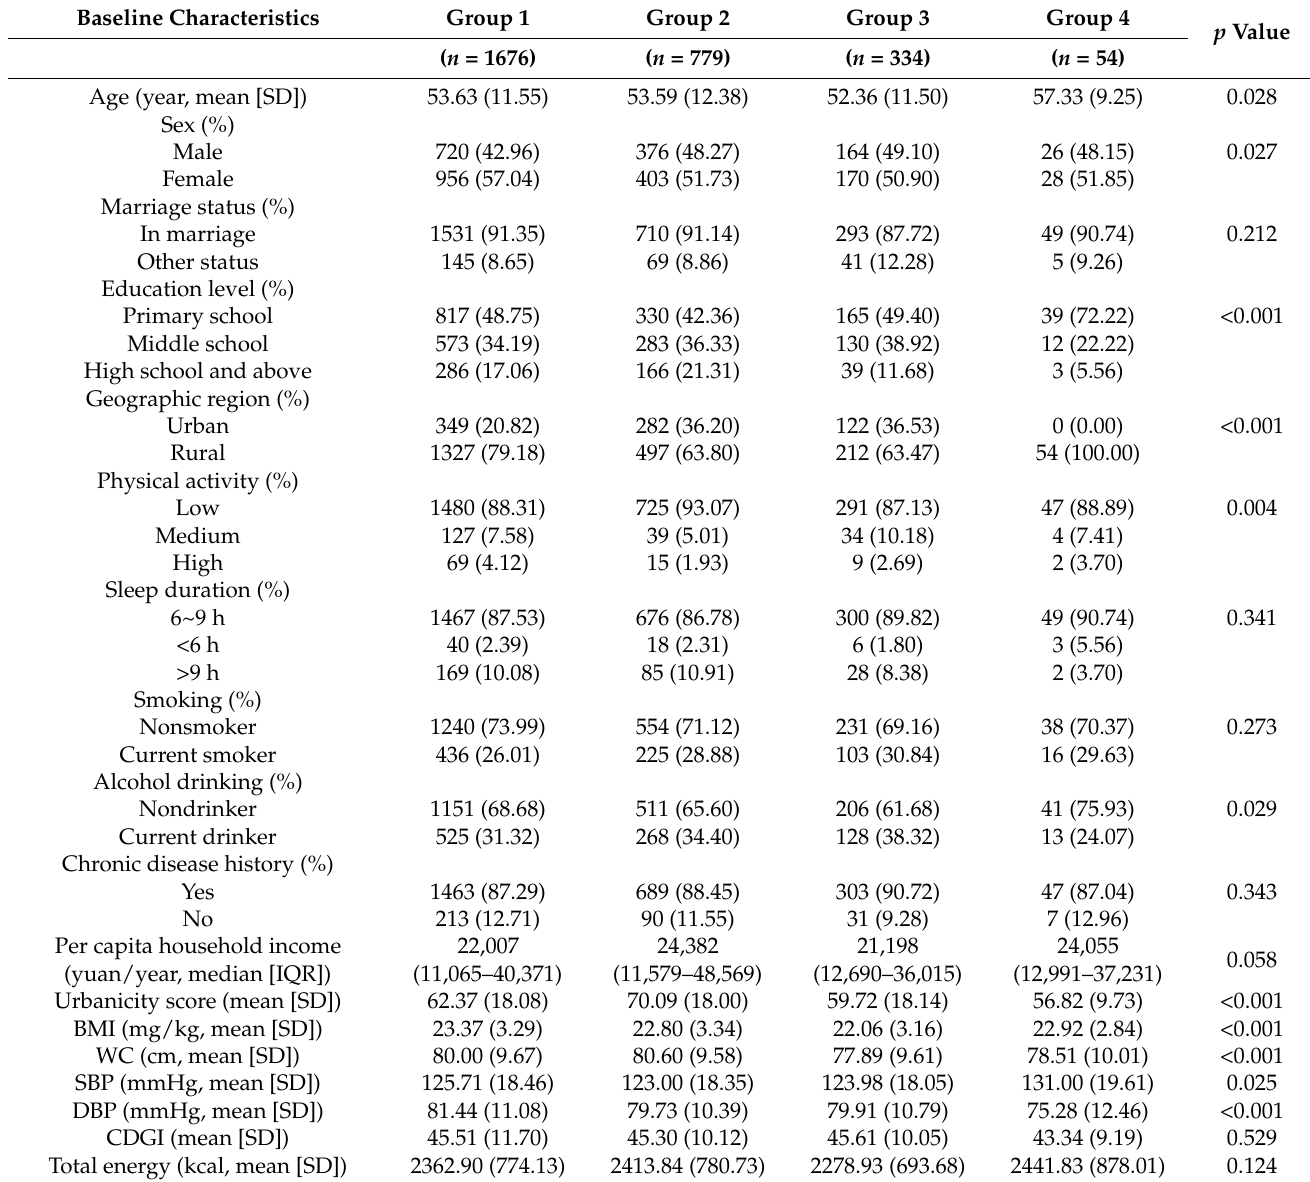
Table 1. Baseline characteristics by the four estimated latent trajectory